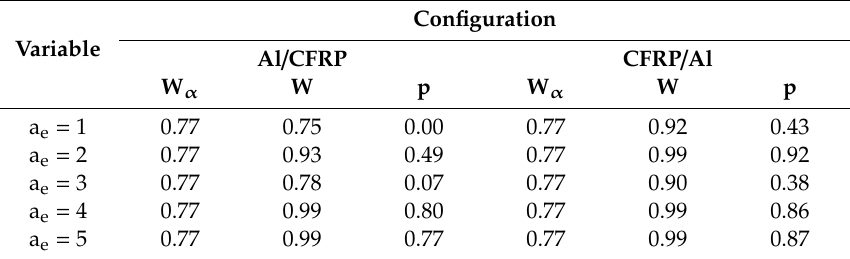
Table 11. Shapiro-Wilk test results for a e variable [27]. Table 11. Shapiro ‐ Wilk test results for a e variable [27].